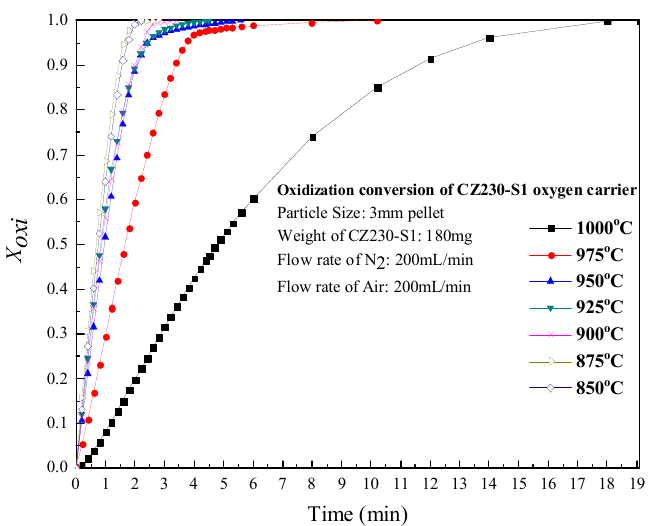
Figure 9. Conversion for oxidation of reduced CZ230-S1 conducted at various operating temperatures.